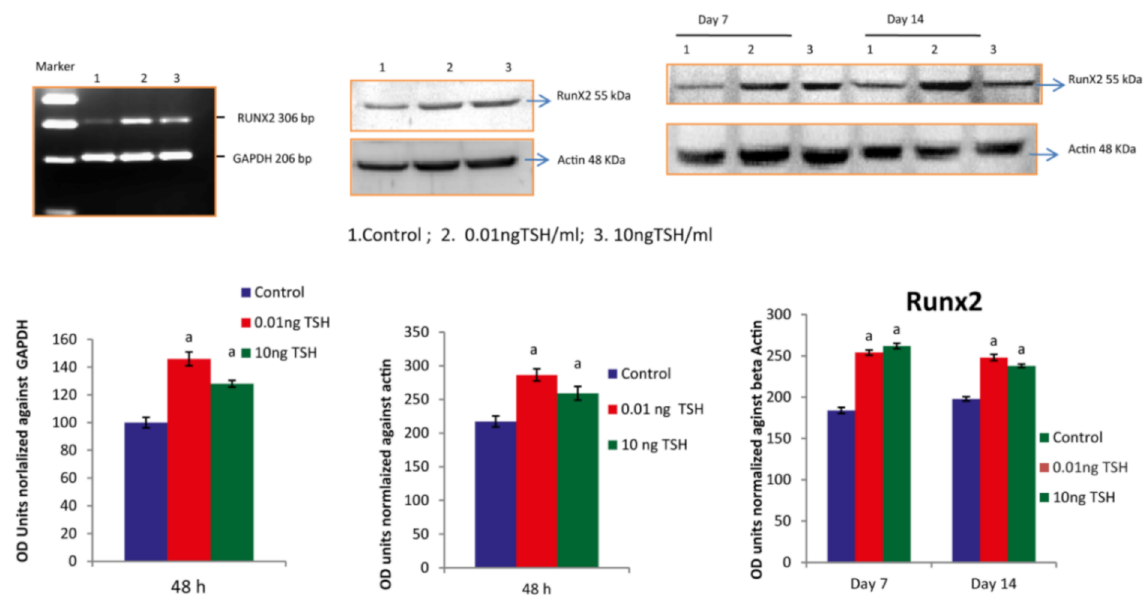
Figure 2. TSH influences Runx2 expression in SaOS-2 cells. Each bar diagram shows mean ± SEM of three experiments; ‘a’ represents compared with control at p <